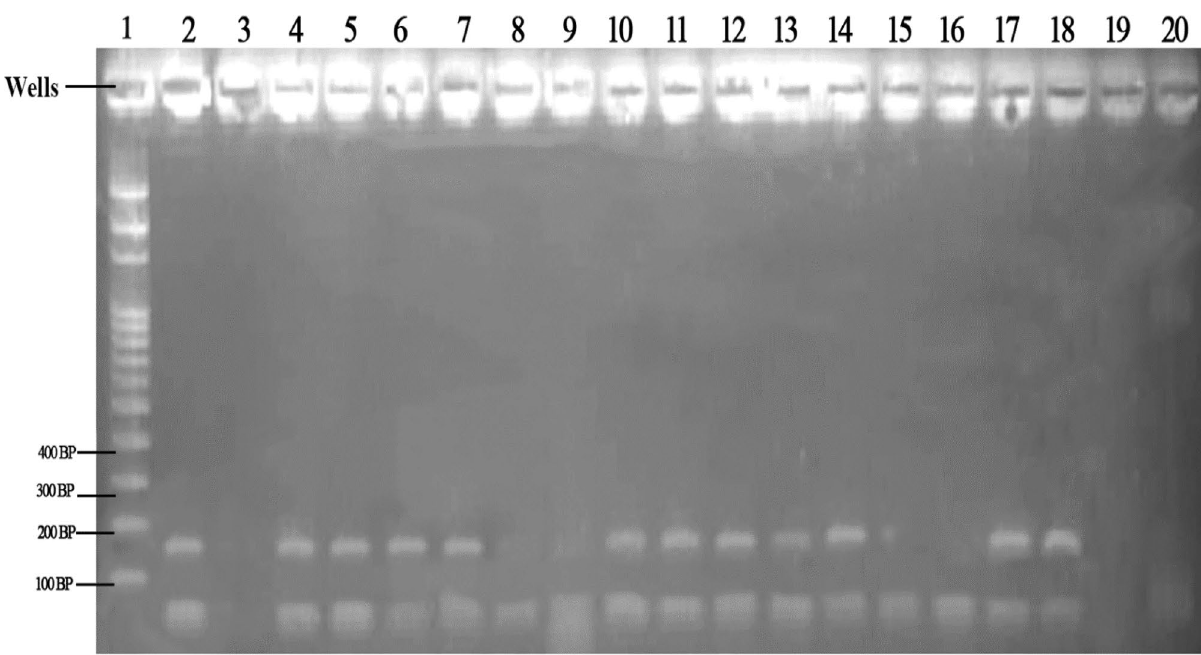
Figure 3. Agarose gel of the DNA fragment of amplified PCR of Anopheles funestus group. Well 1 represent 100 bp DNA ladder. Well 2 a positive control, well 3 a negative control, well 4, 5, 6, 7, 10, 11, 12, 13, 14, 17 and 18 represent Anopheles leesoni 146